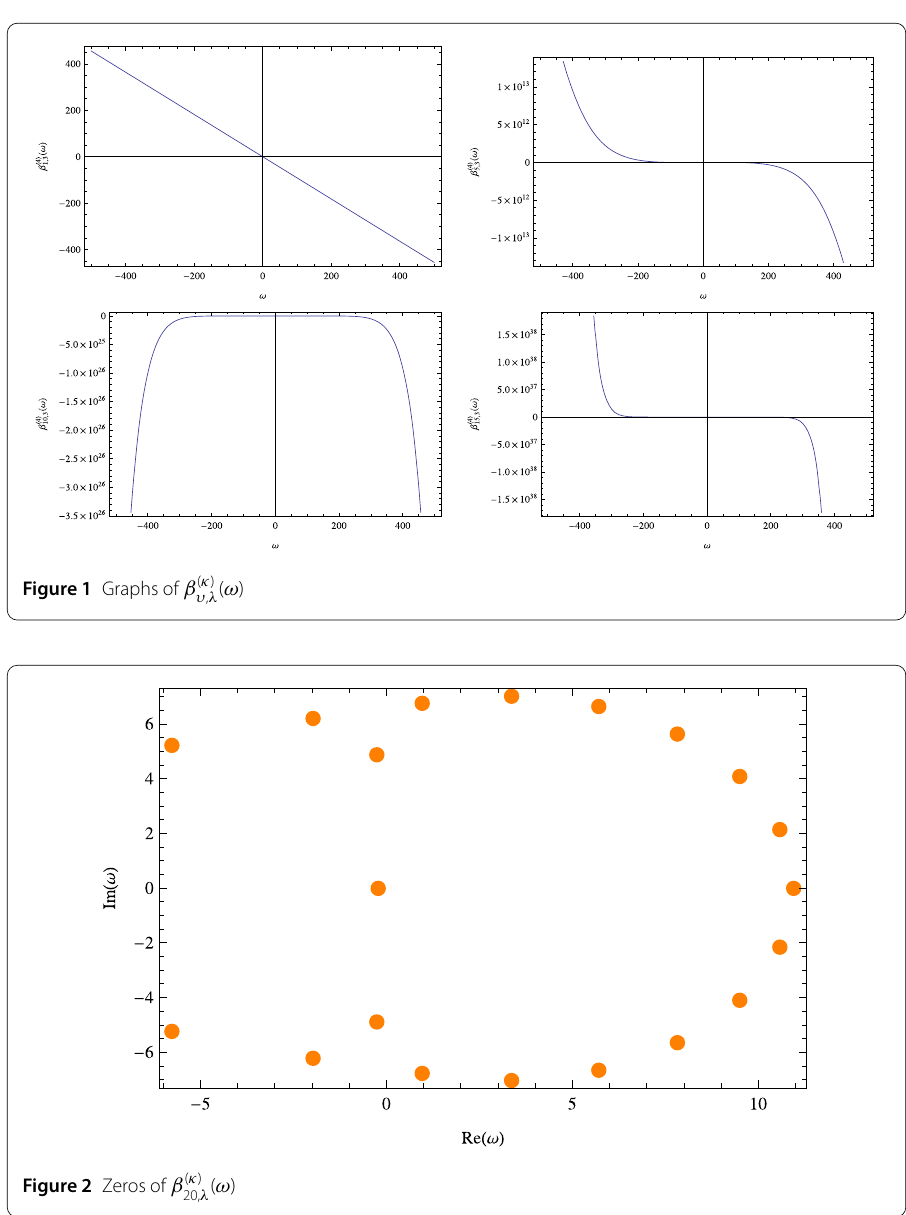
Figure 2 Zeros of β ( κ )